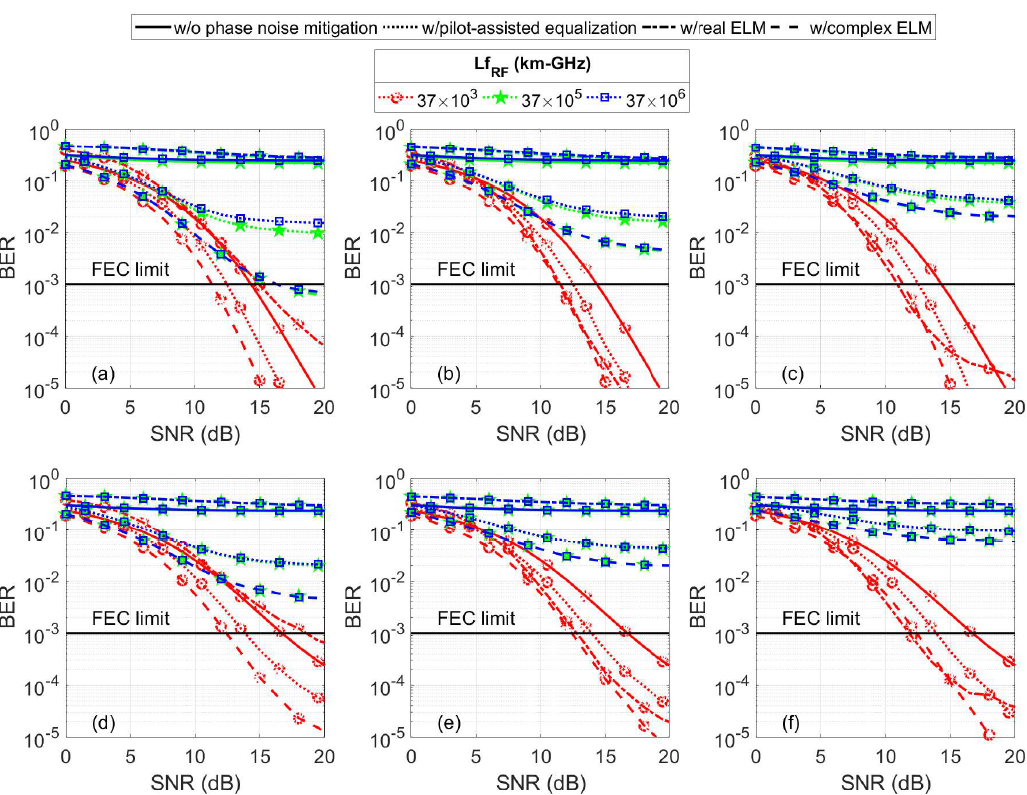
Figure 9. Considering the implemented phase noise reduction mechanisms, the BER against SNR with the product of the fiber length and radio frequency as the parameter. The laser linewidth and OFDM symbol period correspond to ( a ) 0.5 MHz and 32 ns, ( b ) 0.5 MHz and 64 ns, ( c ) 0.5 MHz and 128 ns, ( d ) 1 MHz and 32 ns, ( e ) 1 MHz and 64 ns, and ( f ) 1 MHz and 128 ns,